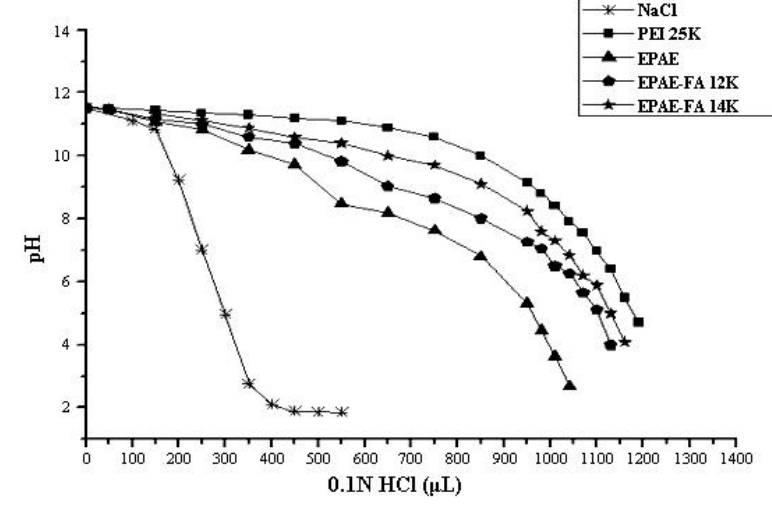
Figure 4. Acid-base titration profile of various polymers with 0.1 N